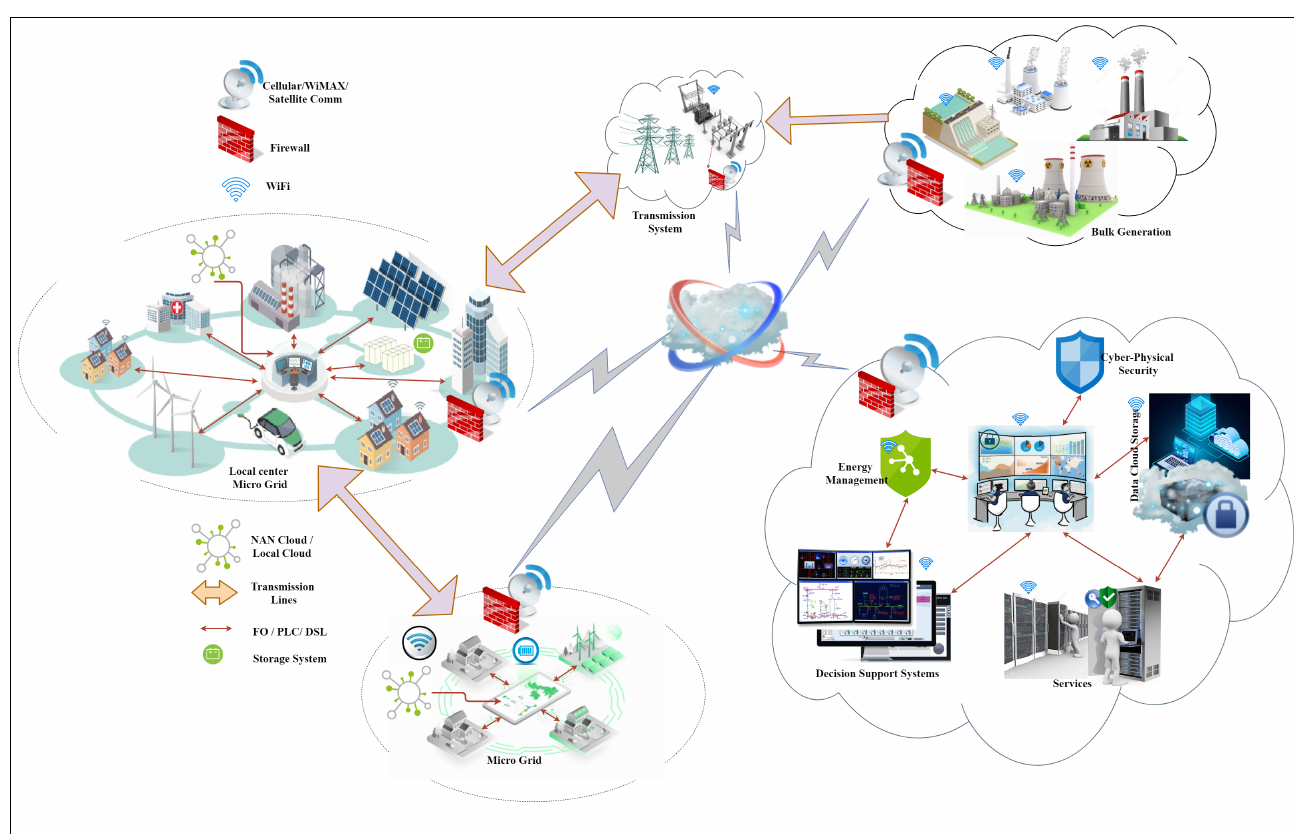
Figure 1. Typical Architecture of CP-SG Conceptual